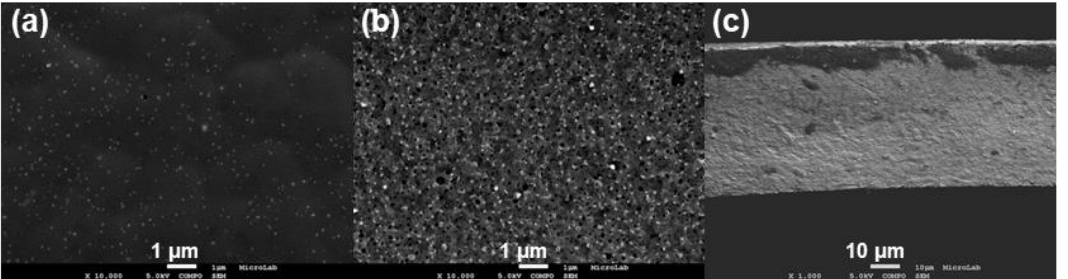
Figure 9. FESEM images of ( a ) active layer, ( b ) porous layer, and ( c ) cross-section of CA30Ag0.1 membrane (adapted from Ref. [8]. 2014, John Wiley and Sons).